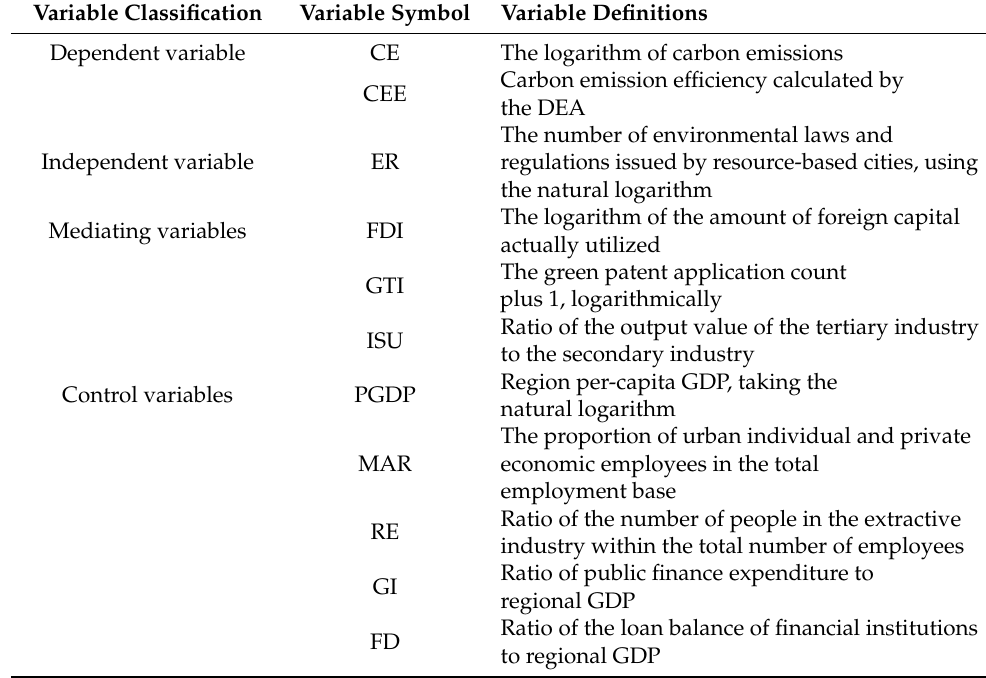
Table 2. Variable definitions.